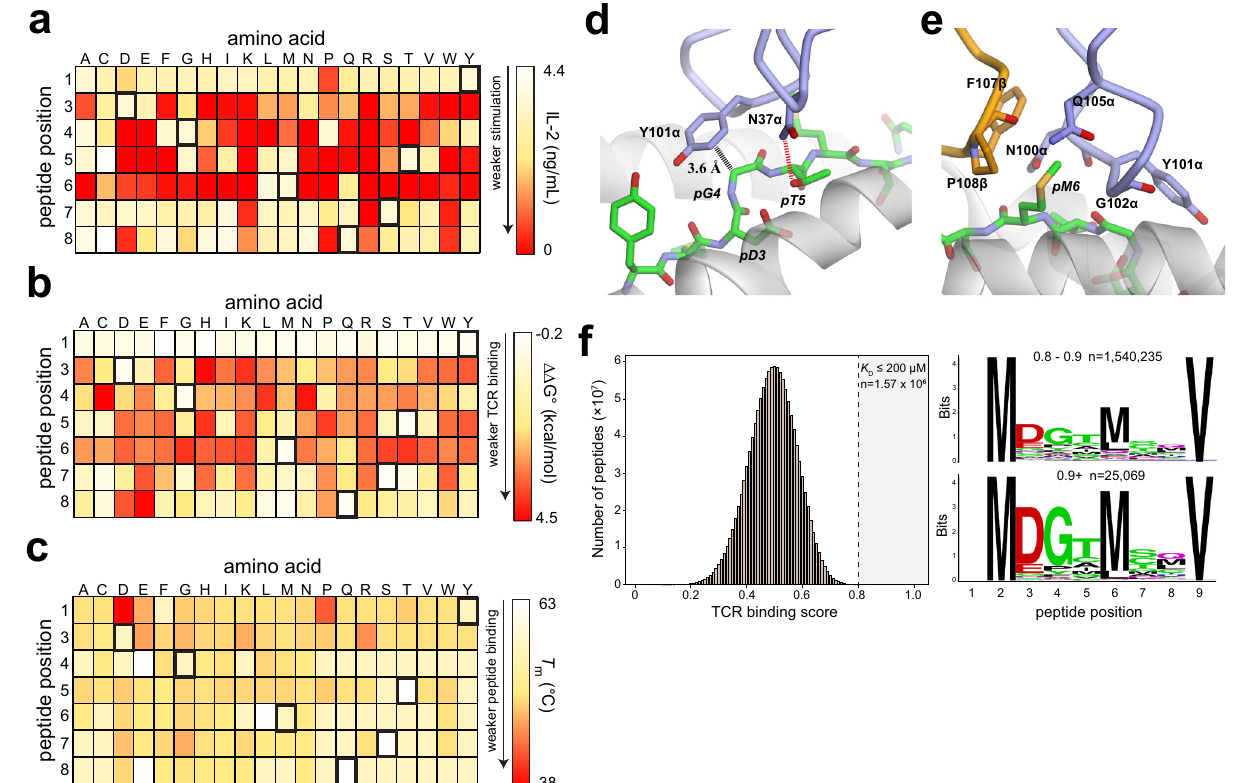
Fig. 5 | Speci fi city within the TIL1383I-Tyr 370D /HLA-A2 interface. a TIL1383I showshighspeci fi cityfortheTyr 370D peptide,asshownbyafunctionalanalysisofa positionalscanninglibraryofthepeptide.Cellsoftheheatmapindicatetheextent of IL-2 released when TCR-transduced Jurkat cellswere mixed with peptide-pulsed HLA-A2 + T2 cells. The color scale is on the right, with red indicating a loss of T-cell recognition. b Assessment of the positional scanning Tyr 370D library by a novel TCR-binding assay with UV-exchanged peptide/HLA-A2 complexes. Cells of the heat map indicate the change in TCR-binding free energy relative to the wild-type peptide. The color scale is again on the right, with red indicating the largest reduction in binding free energy. There is good concurrence between the func- tional and binding analysis of the library. c Assessment of the UV-exchanged pep- tide/HLA-A2 library panel b using differential scanning fl uorimetry to measure T m